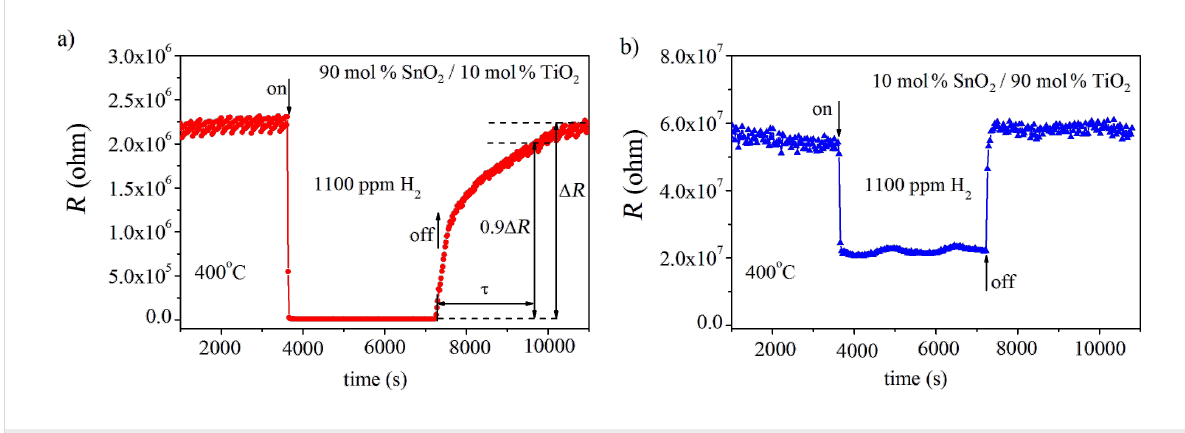
Figure 6: Dynamic changes in the electrical resistance, R , of: a) 90 mol % SnO 2 /10 mol % TiO 2 ; b) 10 mol % SnO 2 /90 mol % TiO 2 heterostructures upon interaction with 1100 ppm H 2 . τ denotes the recovery time.